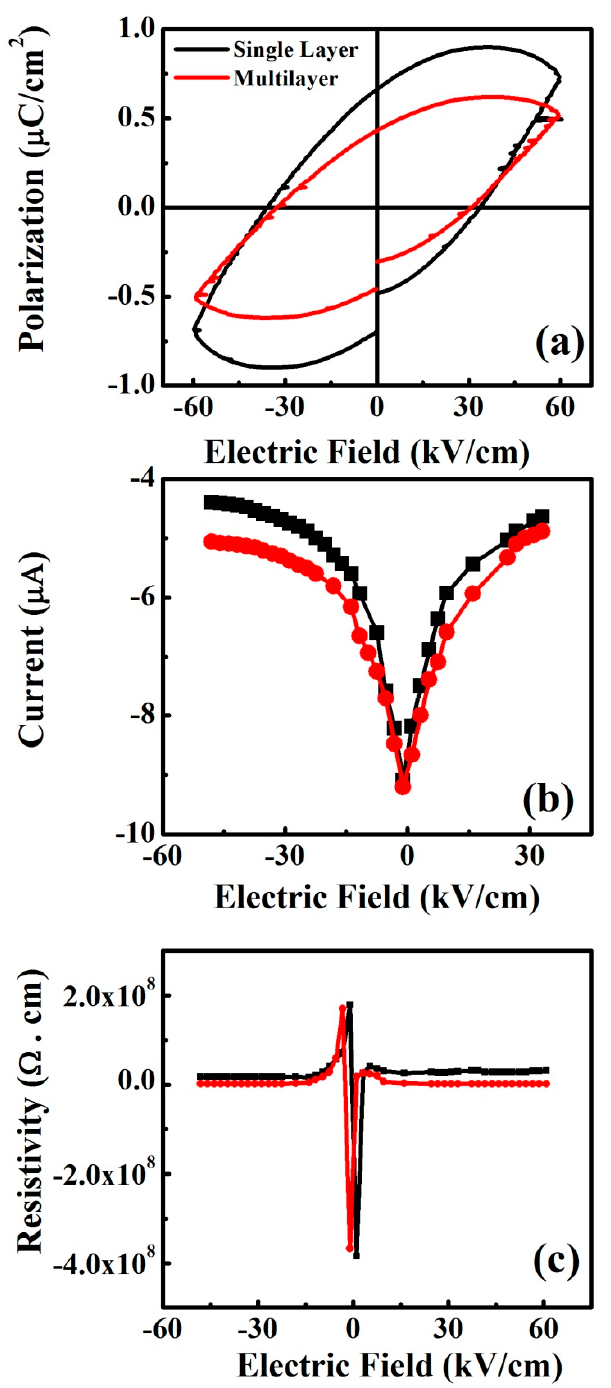
Figure 4. ( a ) Ferroelectric ( P-E ) loops for single-layer and multilayered CH 3 NH 3 PbIBr 2 thinfilms, ( b ) current versus applied electric field for single-layer and multilayered CH 3 NH 3 PbIBr 2 thinfilms, ( c ) resistivity versus applied electric field single-layer and multilayered CH 3 NH 3 PbIBr 2